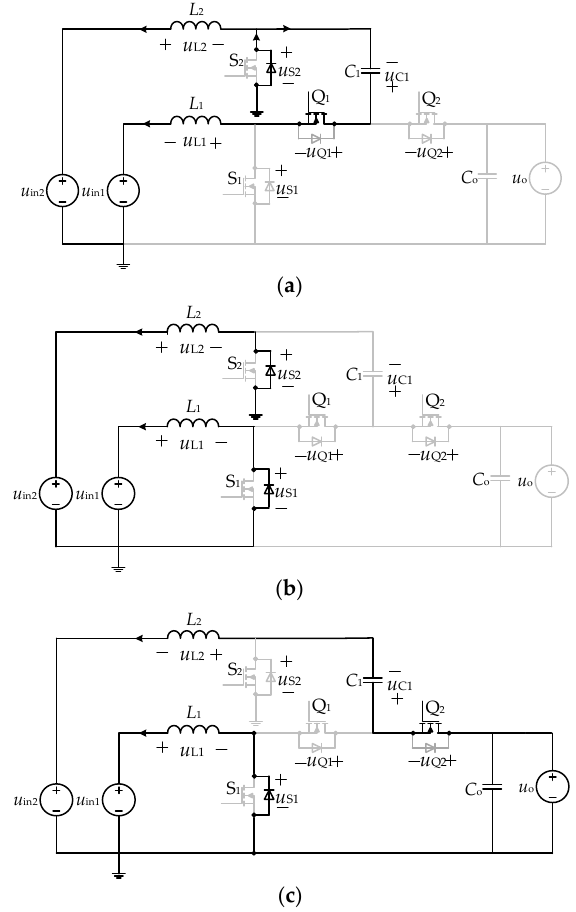
Figure 6. The equivalent circuits in the charging mode for ( a ) Sub-mode 1; ( b ) Sub-mode 2; ( c ) Sub-mode 3.